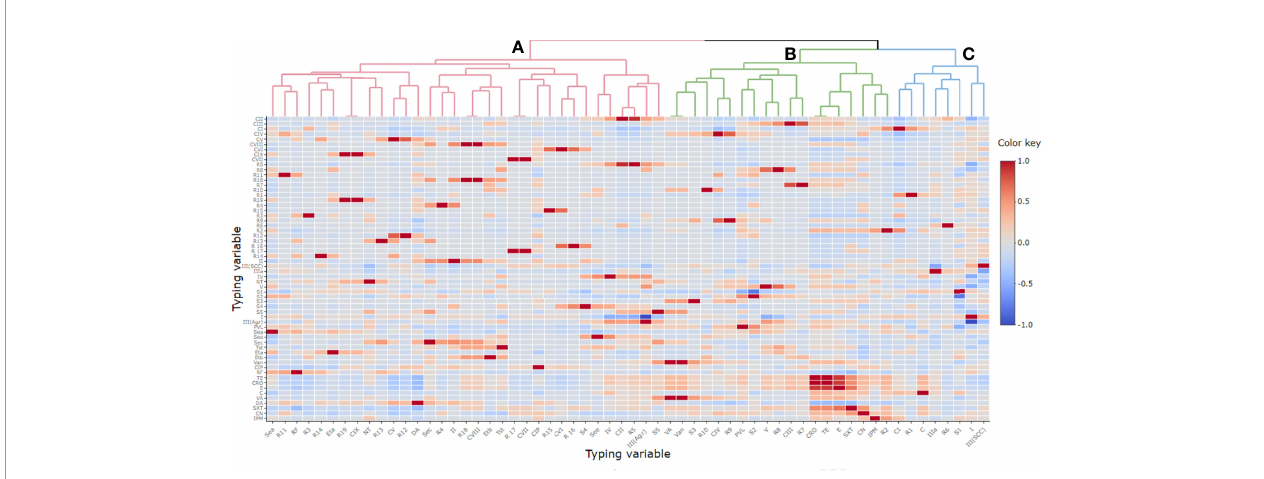
FIGURE 3 | Pairwise correlation ( r ) among different variables of typing methods. Red and blue colors indicate positive and negative correlation, respectively. The color key refers to correlation coef fi cient ( r ). The darker colors imply stronger positive or negative correlations. Hierarchical clustering of the variables is shown as a dendrogram illustrating differentclusters with different colors and letters(e.g., (A – C) . Variables that areidenticalamongallstrains are excluded and thus not shownin this fi gure. CIP, cipro fl oxacin; RF, rifamycin SV; TE, tetracycline; CRO,ceftriaxone; E, erythromycin; C, chloramphenicol; VA, vancomycin; DA, clindamycin; SXT, trimethoprim ‐ sulfamethoxazole; CN, gentamicin; IPM, imipenem; CI-CIX, coagulase genotypes; R1 – R19, coa -RFLP patterns; SCC mec ( II , III , IV , and V ), staphylococcal cassette chromosome mec ; NT, non-typeable; agr ( I and III ), accessory gene regulator; S1 – S5, spa PCR products; van , vancomycin resistance gene; pvl , Panton – Valentine leucocidin; sea , see , and sec ; staphylococcal enterotoxins A, B, and C; tst , toxic shock syndrome toxin; eta and etb , exfoliative toxins A and B.